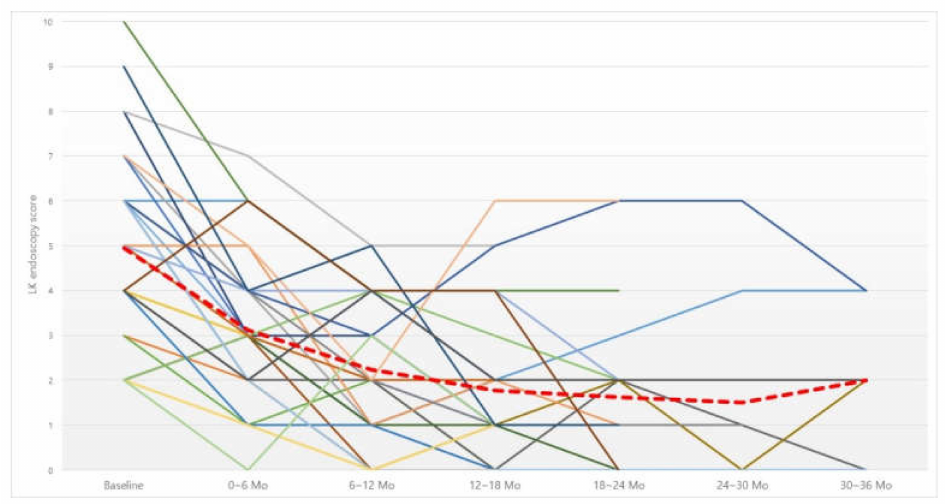
Figure 3. Changes in Lund–Kennedy (LK) endoscopy score. Red dotted line, average of LK endoscopy score. Abbreviation: Mo,